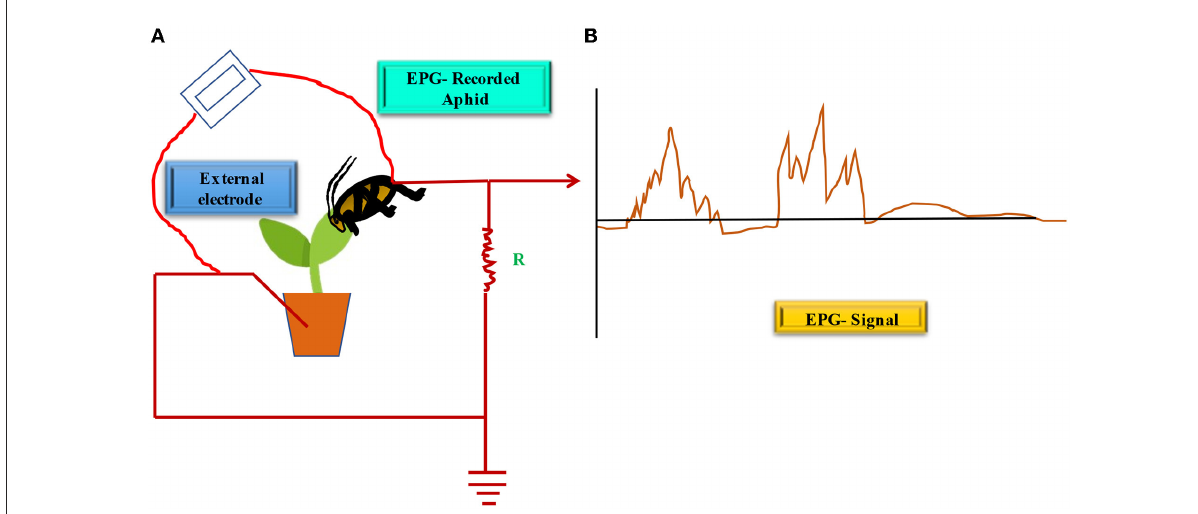
FIGURE4 EPG studies on potato-aphid interactions showing PVY transmission. (A) Depicts EPG system set-up with waveform pattern, (B) Represents typical waveforms corresponding to different feeding phase and several potential drop (pd) phases are depicted according to different feeding functions. (Adopted from Martin et al., 1997).